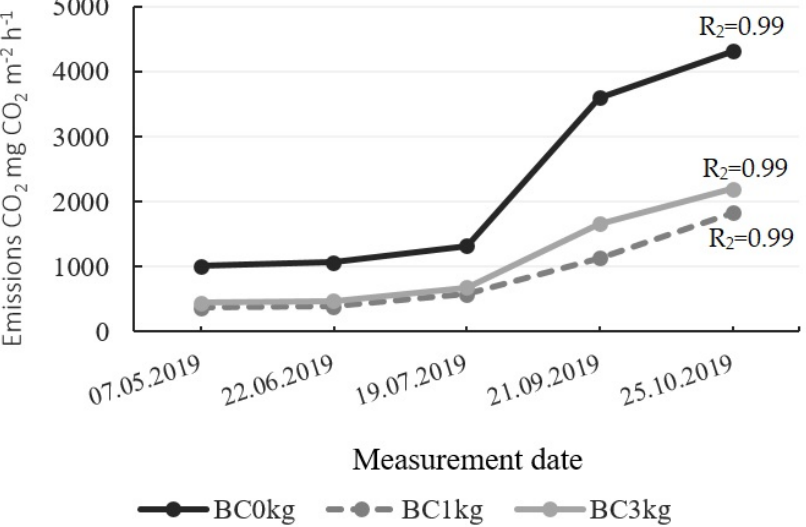
Figure 4. Cumulative CO 2 flux in the area without biochar (BC0), from 1 kg/m 2 (BC1kg), and from 3 kg/m 2 (BC3kg) for the growing season of 2019.